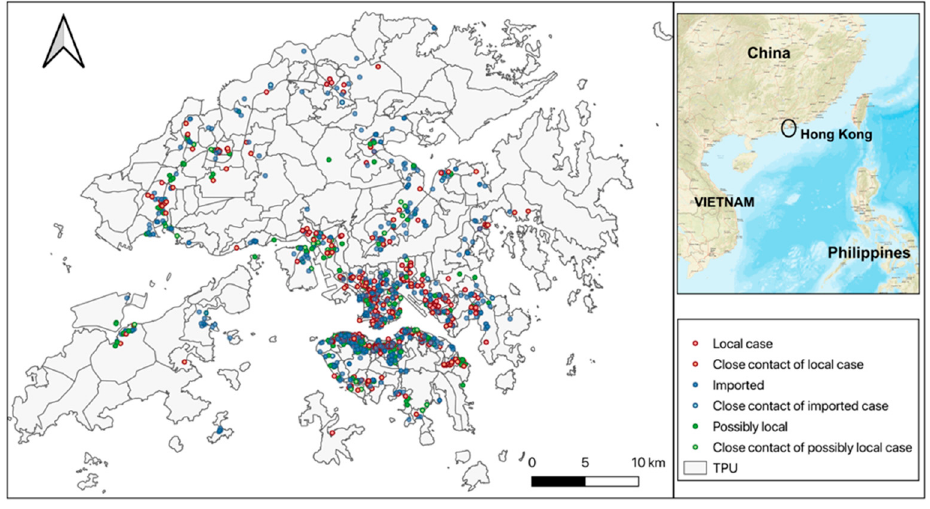
Figure 1. Study area and the residential spatial distribution of the confirmed cases (TPU, Hong Kong Tertiary Planning Unit).